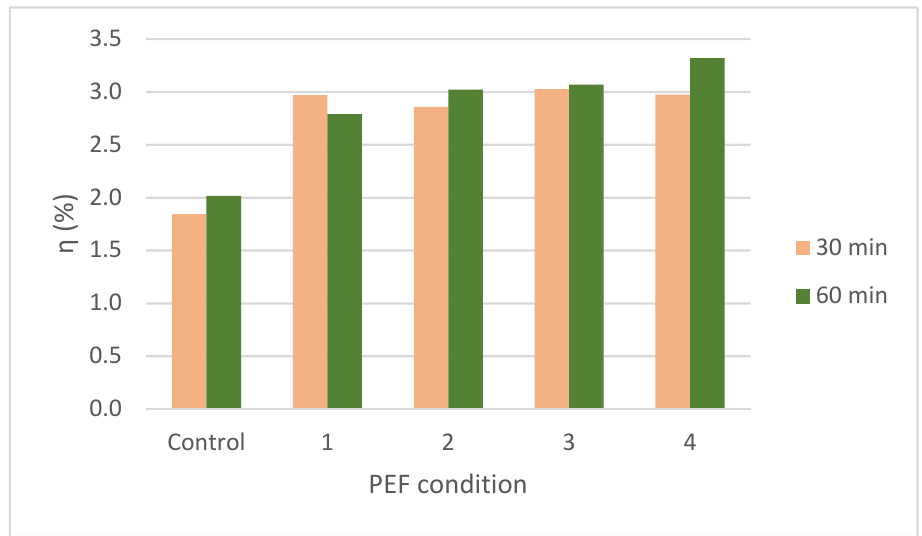
Figure 5. Results of yield thyme EO extracted with and without (Control) PEF application and different distillation times.